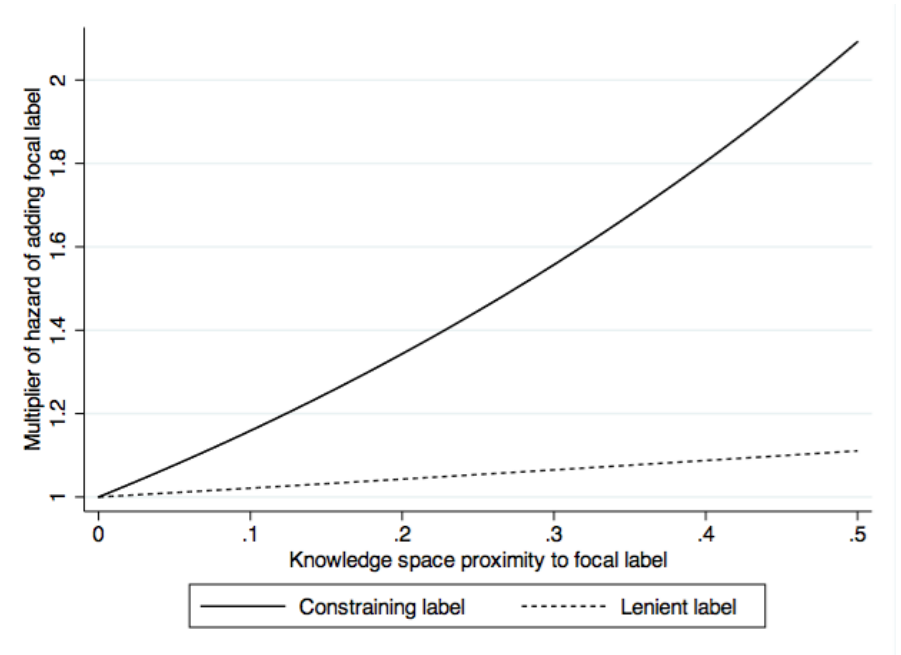
Figure 5: Effects of knowledge proximity on the hazard of adding a label, by leniency (from Table 3, model